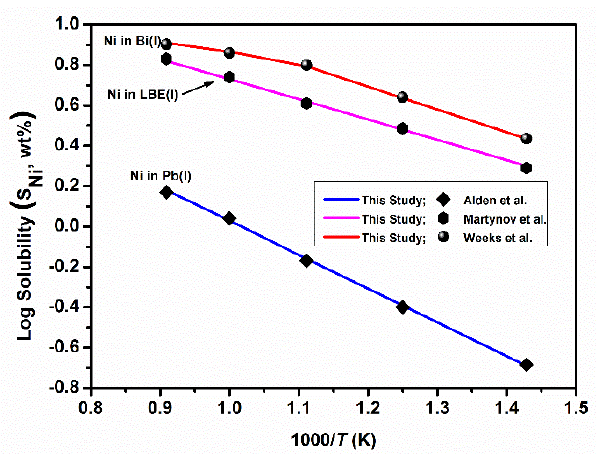
Figure 6. Solubility of Ni in liquid Pb, Bi and LBE and compared with experimental data (Alden et al. [50], Martynov et al. [55], Weeks et al. [56].